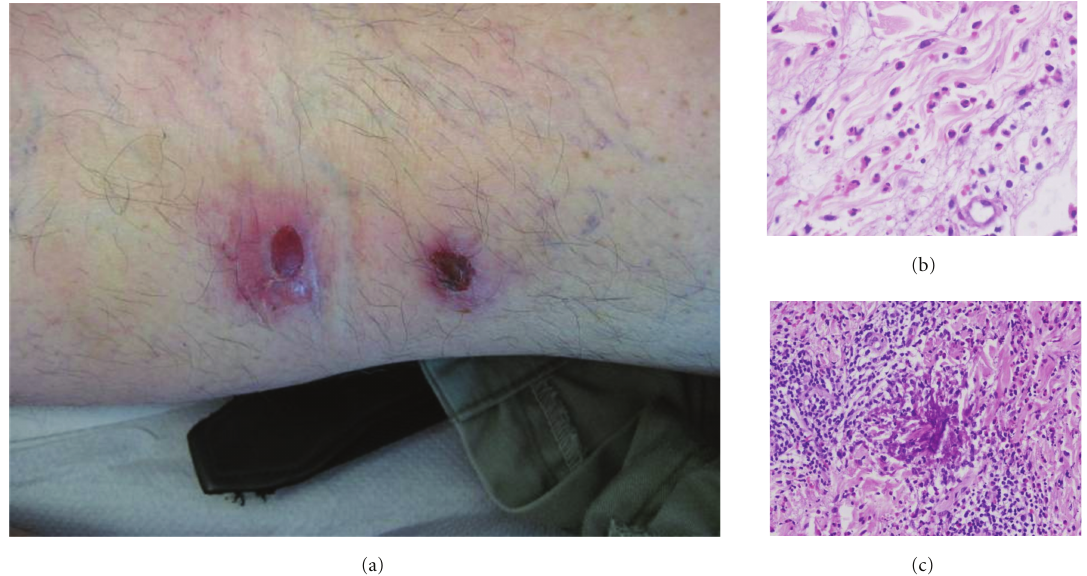
Figure 2: (a) Prurigo-like lesions with central crust mimicking arthropod bites. (b) Interstitial dermal infiltration composed by eosinophils. (c) Flame